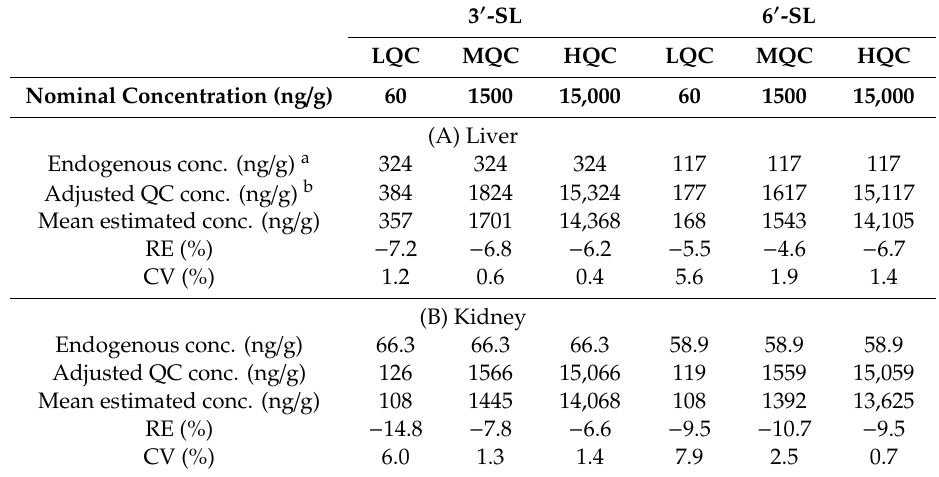
Table 4. Assessment of parallelism between surrogate matrix and authentic matrix.